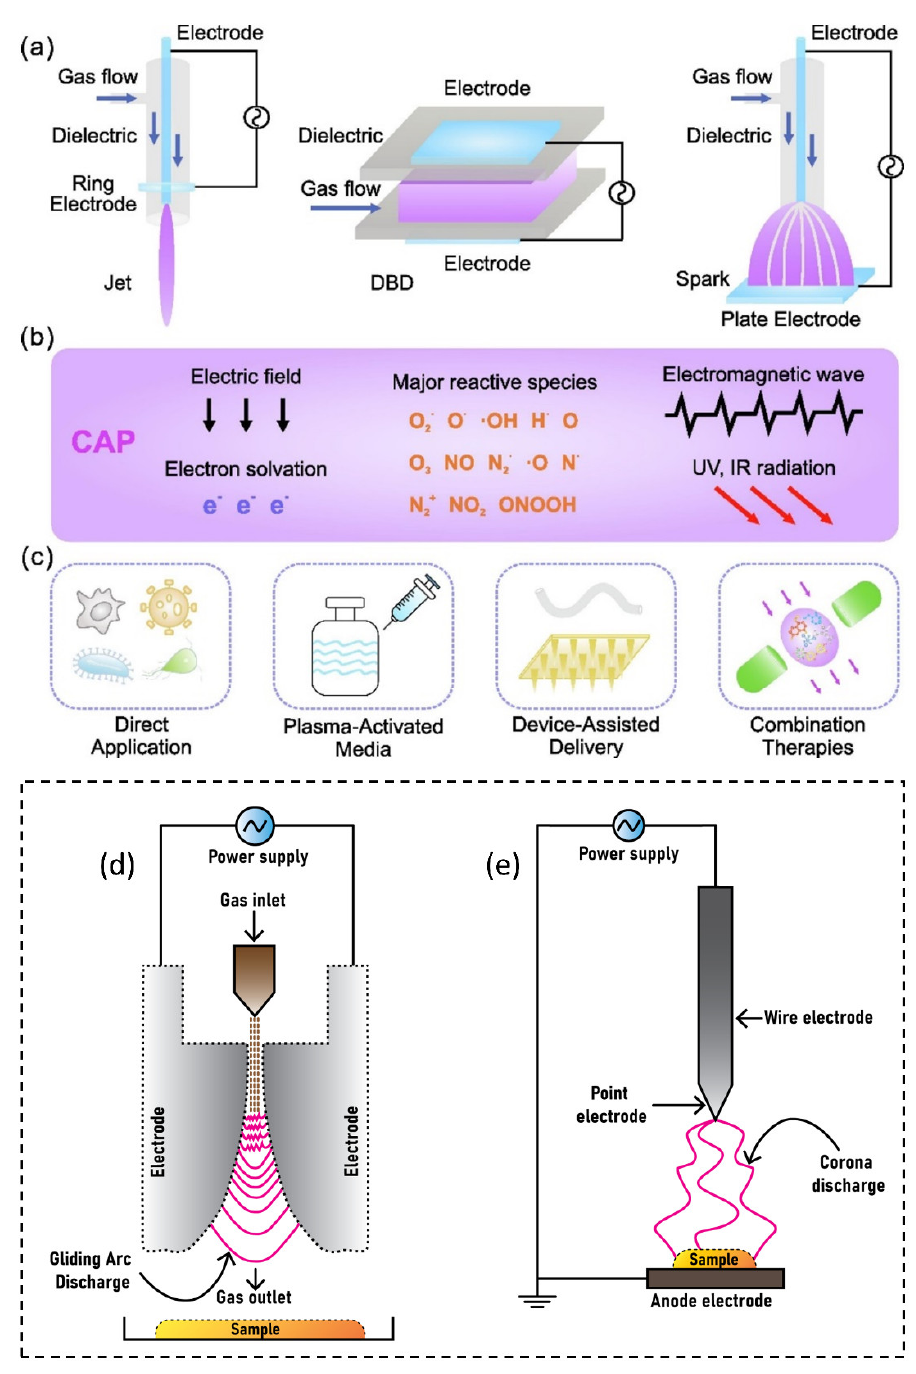
Figure 2. NTP delivery schematic for biomedical applications: ( a ) typical NTP devices, including plasma jet, DBD, and spark discharge; ( b ) plasma environment containing reactive species, electrons, other ions, emissions, waves, and physical forces; and ( c ) plasma delivery strategies, including direct application, plasma-activated media, device-assisted delivery, and therapeutic approaches. Reprinted with permission from Ref. [1]. Copyright 2022, Elsevier. The most common devices used for environmental applications are ( d ) gliding arc discharge plasma and ( e ) corona discharge plasma.